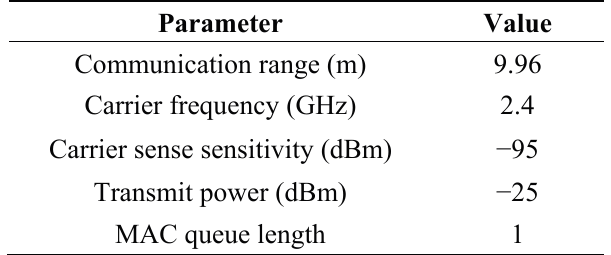
Table 1. Main physical and link layer simulation